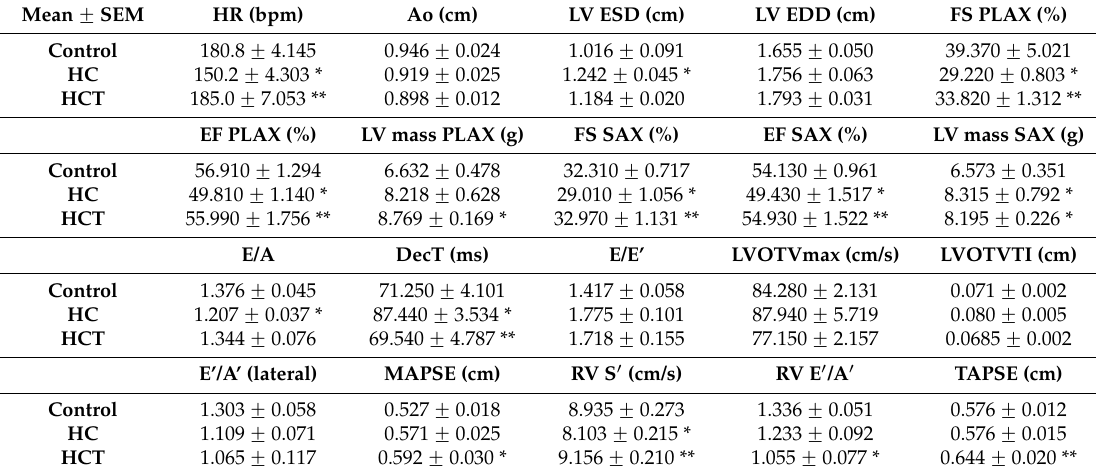
Table 1. Echocardiographic outcomes. Outcomes of echocardiographic evaluations on animals fed normal cholesterol-free rabbit chow (control); normal rabbit chow, containing 2% cholesterol (hypercholesterolemic, HC); rabbit chow containing 2% cholesterol + 2% WGLL (hypercholesterolemic treated, HCT). Outcomes evaluated included the following: heart rate (HR); beats per minute (bpm); aortic diameter (Ao); left ventricle (LV); right ventricle (RV); end-systolic diameter (ESD); end-diastolic diameter (EDD); parasternal long axis view (PLAX); short axis view (SAX); fractional shortening (FS) of the left ventricle; ejection fraction of the left ventricle (EF); calculated weight of the left ventricle (LV mass); peak mitral early diastolic inflow velocity/peak atrial diastolic inflow velocity (E/A); deceleration time of the E wave from maximum to baseline (DecT); peak mitral inflow velocity/average of spectral tissue Doppler peak early diastolic velocities at the septal and lateral corner of mitral annulus (E/E’); maximal velocity of left ventricle outflow (LVOTVmax); left ventricle outflow tract velocity time integral (LVOTVTI); peak early diastolic velocity of the lateral wall, spectral tissue Doppler/peak atrial diastolic velocity of the lateral wall, spectral tissue Doppler (E’/A’); peak systolic velocity (S); mitral annular plane systolic excursion (MAPSE); and tricuspidal annular plane systolic excursion (TAPSE). Mean ˘ SEM HR (bpm) Ao (cm) LV ESD (cm) LV EDD (cm) FS PLAX (%)